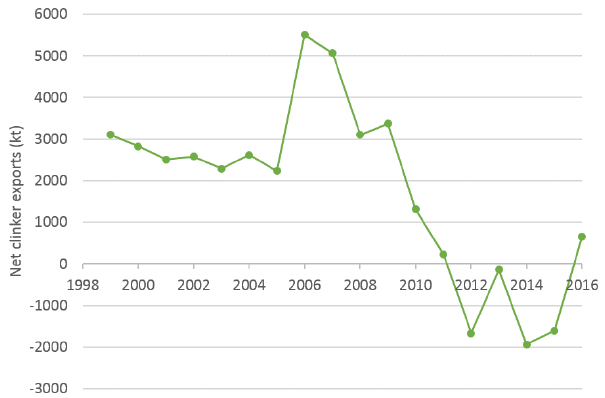
Figure C21. Indonesian clinker production and derived consump- tion, 2000–2012.